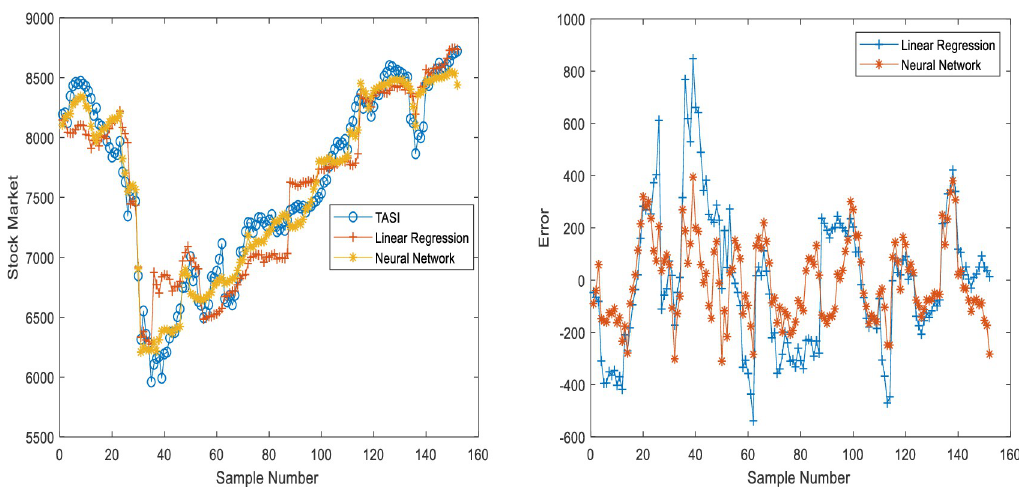
Fig 2. Performance analysis of training datasets using (a) predicted values and (b) Error functions based on neural network and linear regression.